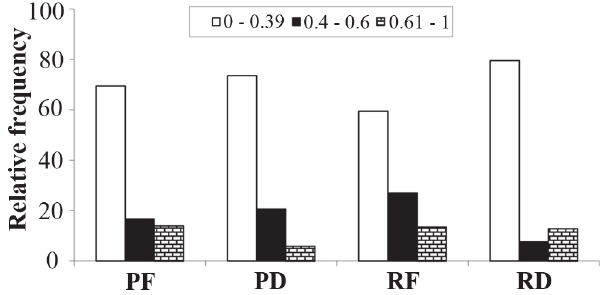
) Fig. 5. Relative frequency of the Pianka’s symmetric index a intervals among all fish species pars, in each spatial-temporal units in the Cuiabá River basin, Mato Grosso State, Brazil. PF = Pond Flood; PD= Pond Drought; RF= River Flood; RD = River Drought. Diet overlap was considered low (0-0.39), intermediate